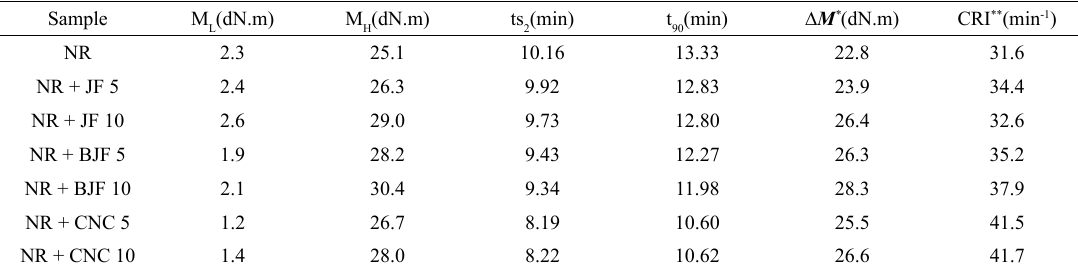
Table 3. Vulcanizing behavior of NR and NR composites at 150 °C Sample